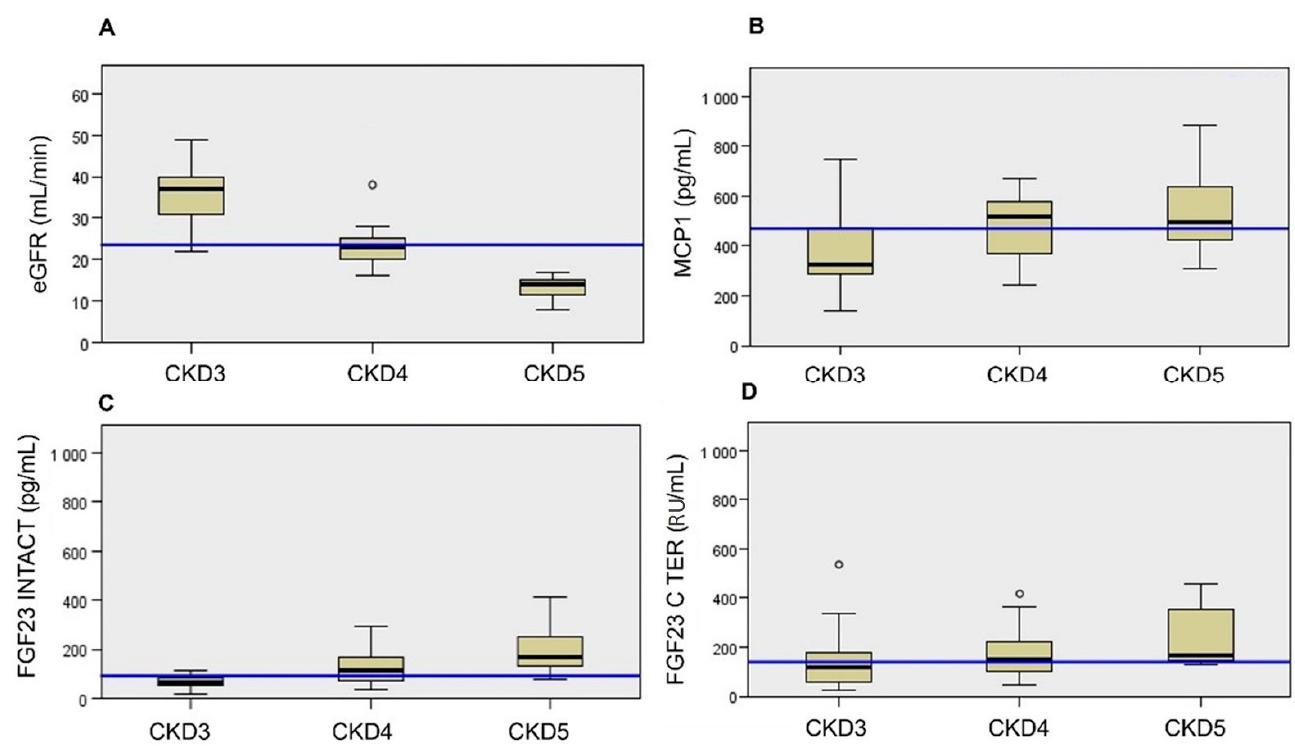
Figure 1. eGFR ( A ), MCP1 ( B ), i/cFGF23 ( C , D ) data according to CKD stage, blue line = median, n = 56 ( n = 19 in CKD3, n = 25 in CKD4, n = 12 in CKD5). ◦ = outliner patients. Table 2. PUFA profile among CKD